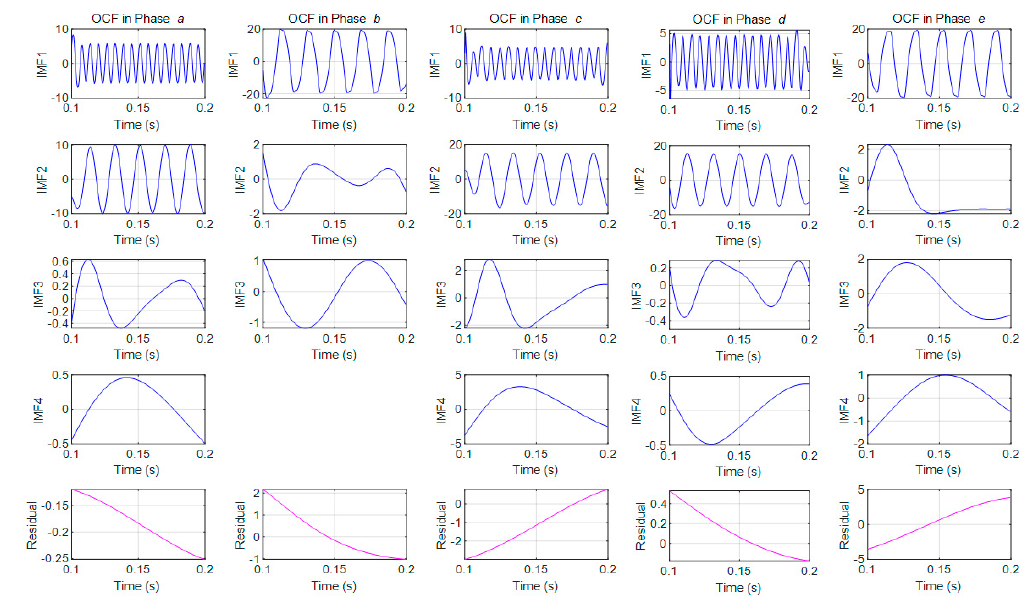
Figure 16. IMFs and residue of direct-axis current in five simulations.